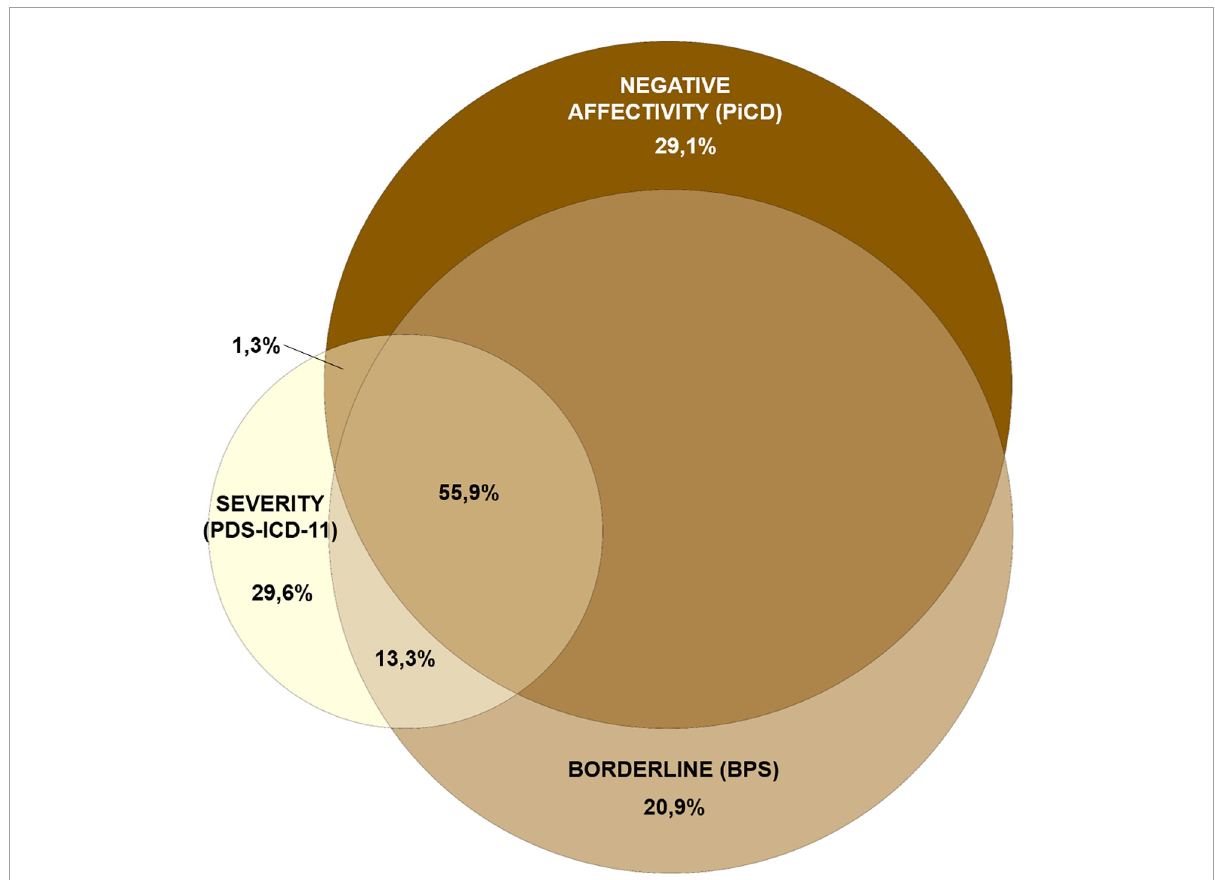
FIGURE1 Euler diagram showing the overlap between negative affectivity, borderline, and severity. Circle sizes are proportional to variances. Due to the geometric impossibility to represent the overlap between more than three variables through a proportionally-built Euler diagram, anankastia and detachment —explaining an additional 2% of the PDS-ICD-11 variance— have been omitted. Drawn at